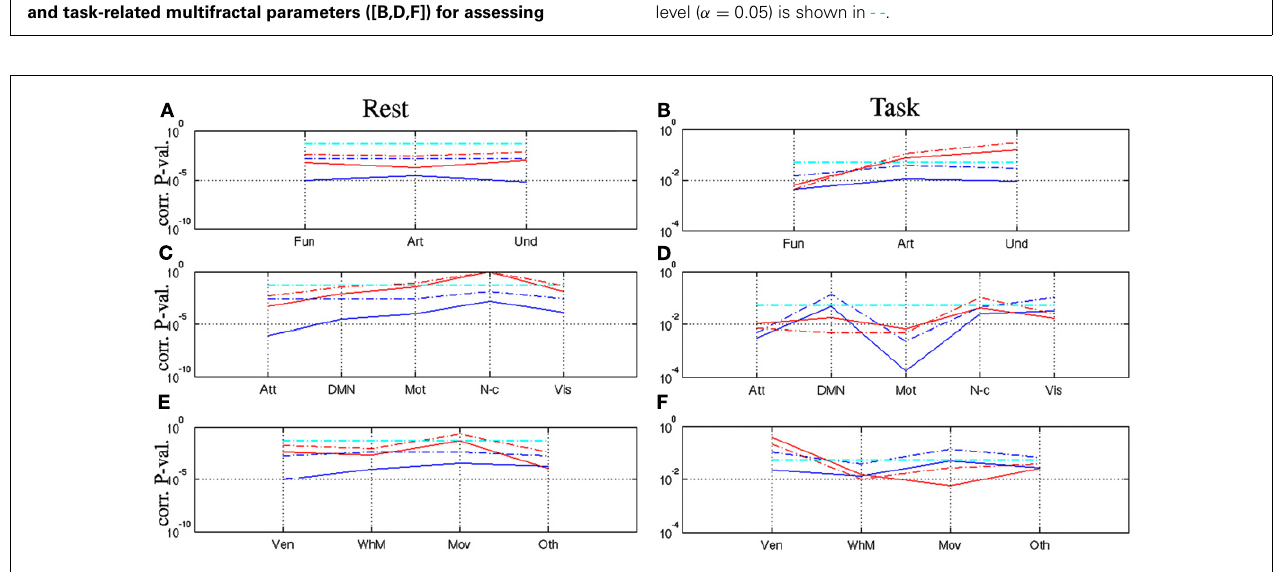
FIGURE 6 | Corrected p-values associated with one-sample Student-t (–,–) andWSR (-.,-.) tests performed on resting-state ([A,C,E]) and task-related multifractal parameters ([B,D,F]) for assessing H ( 1, · )